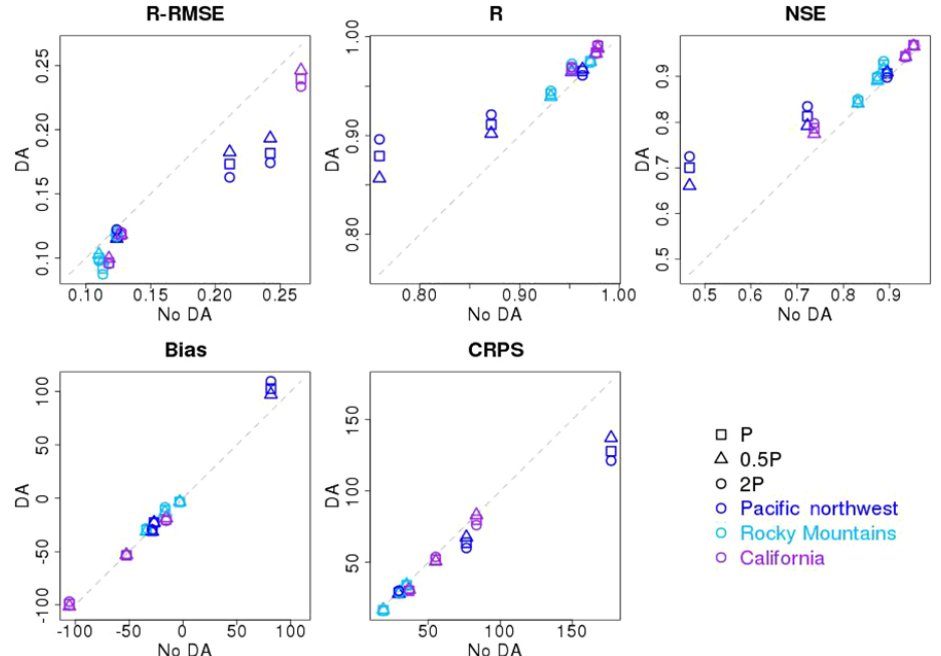
Figure 4. Evaluation metrics for April–July ensemble mean streamflow from the Z score interpolation for the nine case basins using perfect forcing. The verification metrics from upper left to lower right are as follows: R-RMSE is the relative (normalized) root mean squared error, R is the linear (Pearson) correlation coefficient, NSE is the Nash–Sutcliffe efficiency, bias is the same as mean error, and CRPS is the continuous ranked probability skill